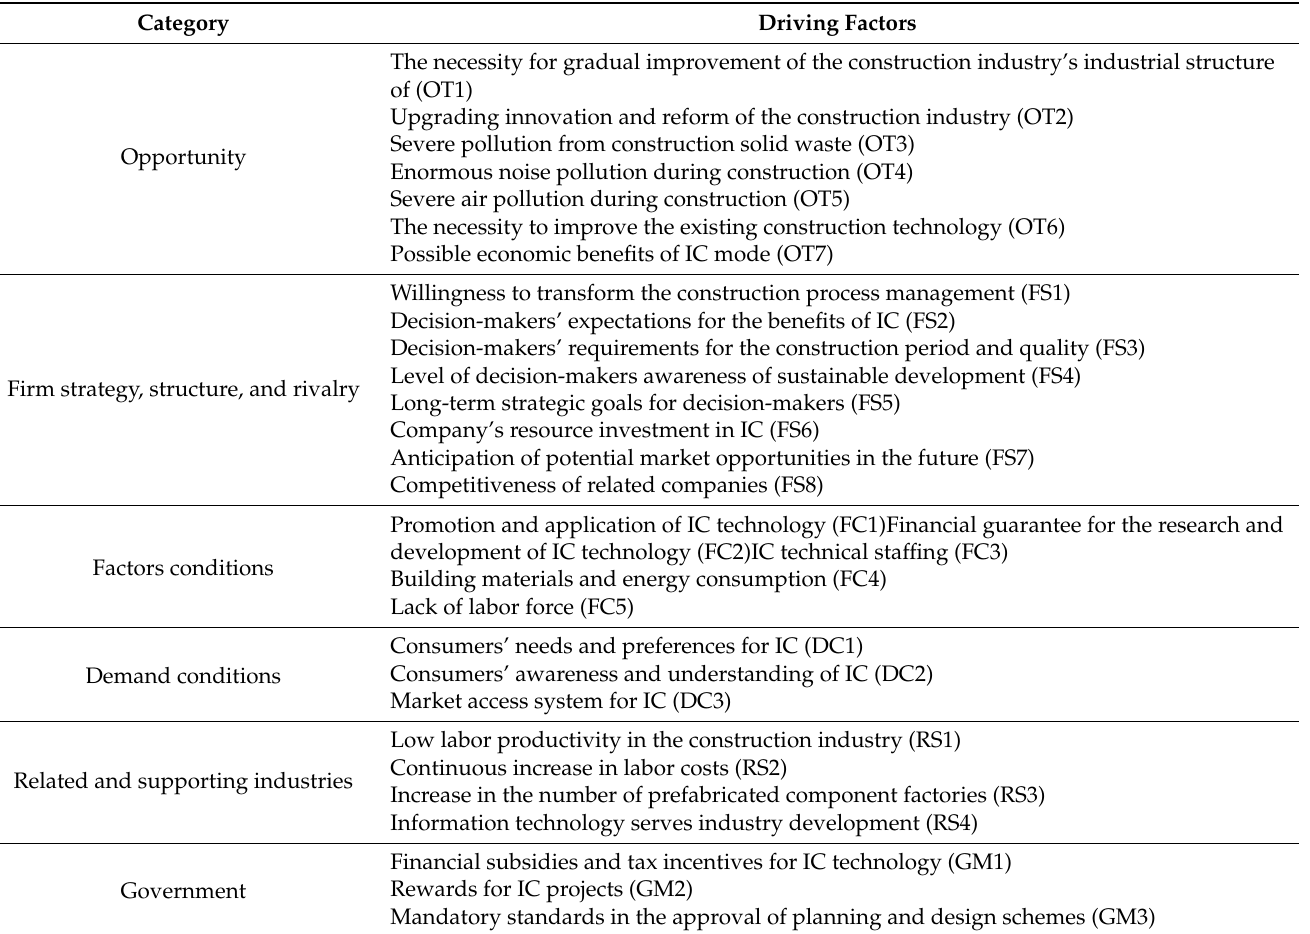
Table 3. Classification of driving factors for the development of